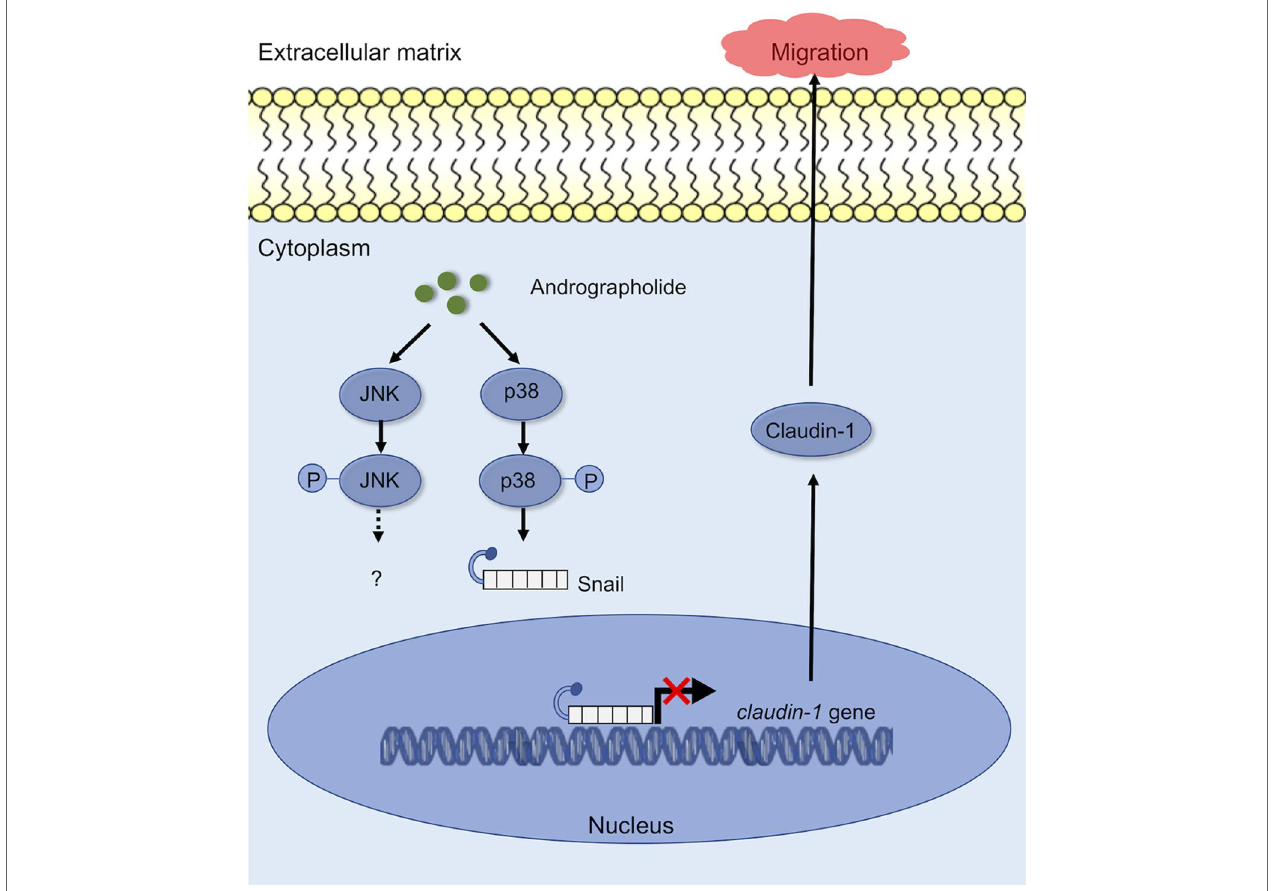
FIGURE 7 | A working model showing the ability of andrographolide to regulate the migration ability of CCA